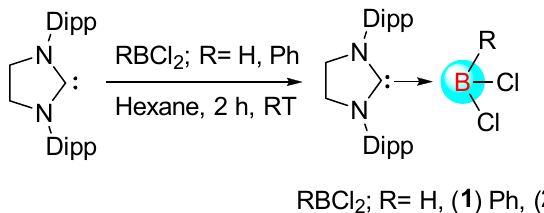
Scheme 1. Synthesis of 5-SIDipp · RBCl 2 adducts 1 and 2 .